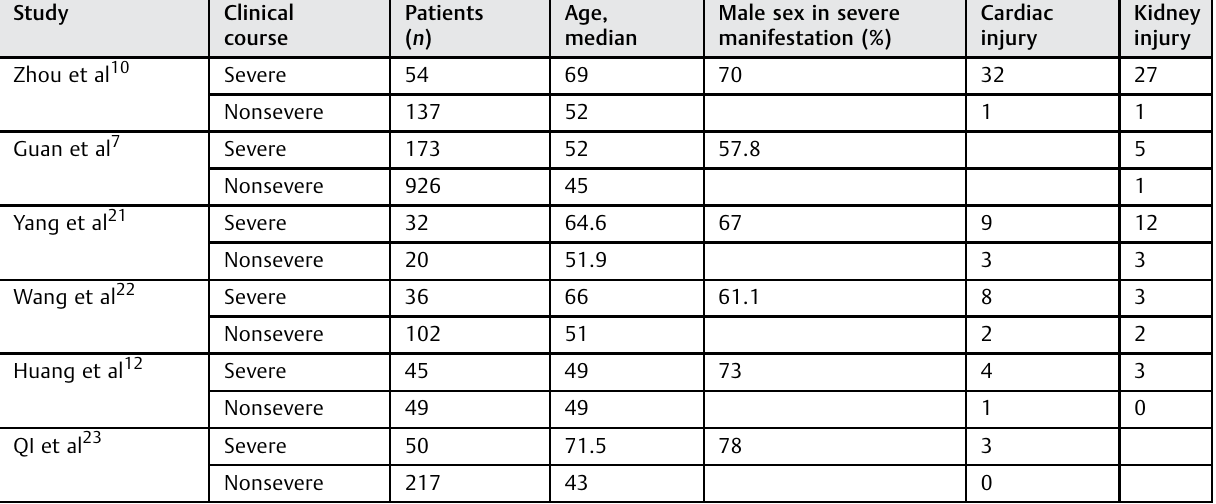
Table 1 Cardiac and kidney injury and the clinical course of COVID-19